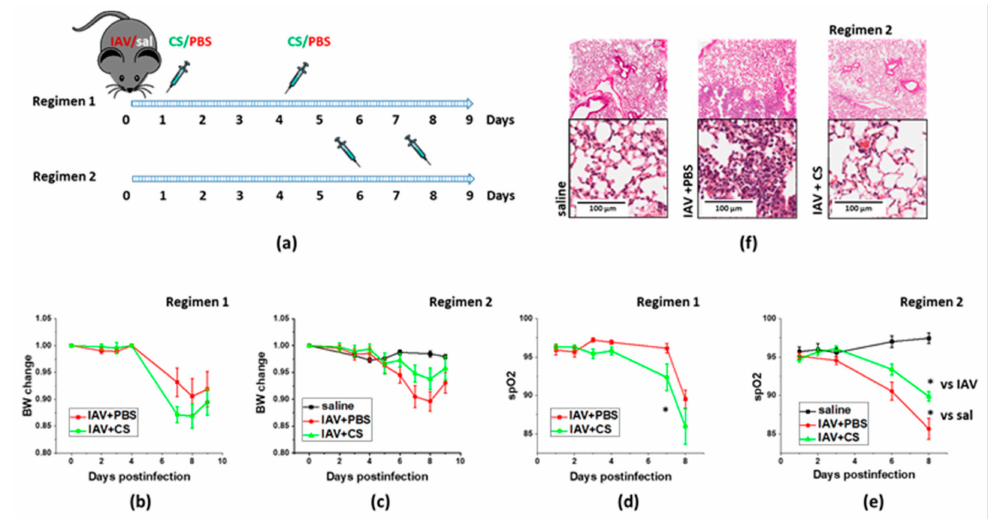
Figure 2. Late ASC-CM administration concomitant with onset of lung injury limits weight loss and lung histopathological changes in response to influenza infection. Schematic of two regimens of therapeutic administration of ASC-CS ( a ). The 12–16-week-old C57Bl/6 mice received intranasal administration of IAV H1N1 PR8 (800 pfu/mouse) on Day0. Control mice received equivalent volume of saline (sal). On the days indicated, mice were sub-cutaneously injected with 2.25 mg/kg of ASC-CS (CS) or an equivalent volume of PBS. Lungs were collected for analyses on Day9. Body weight change in mice subjected to regimen 1 ( b ) or 2 ( c ). Blood oxygenation changes in mice subjected to regimen 1 ( d ) or 2 ( e ). Histopathological changes in H&E-stained lungs from mice subjected to regimen 2 ( f ). Presented are mean +/ − SEM. * for p < 0.05 by t -test with Welch correction (unequal